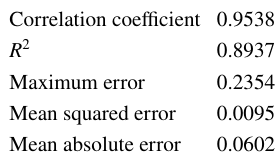
Determination of porosity and permeability of selected samples The procedure of porosity and permeability measurement was explained earlier. Tables 4 and 5 indicate porosity and permeability for selected chips, respectively.